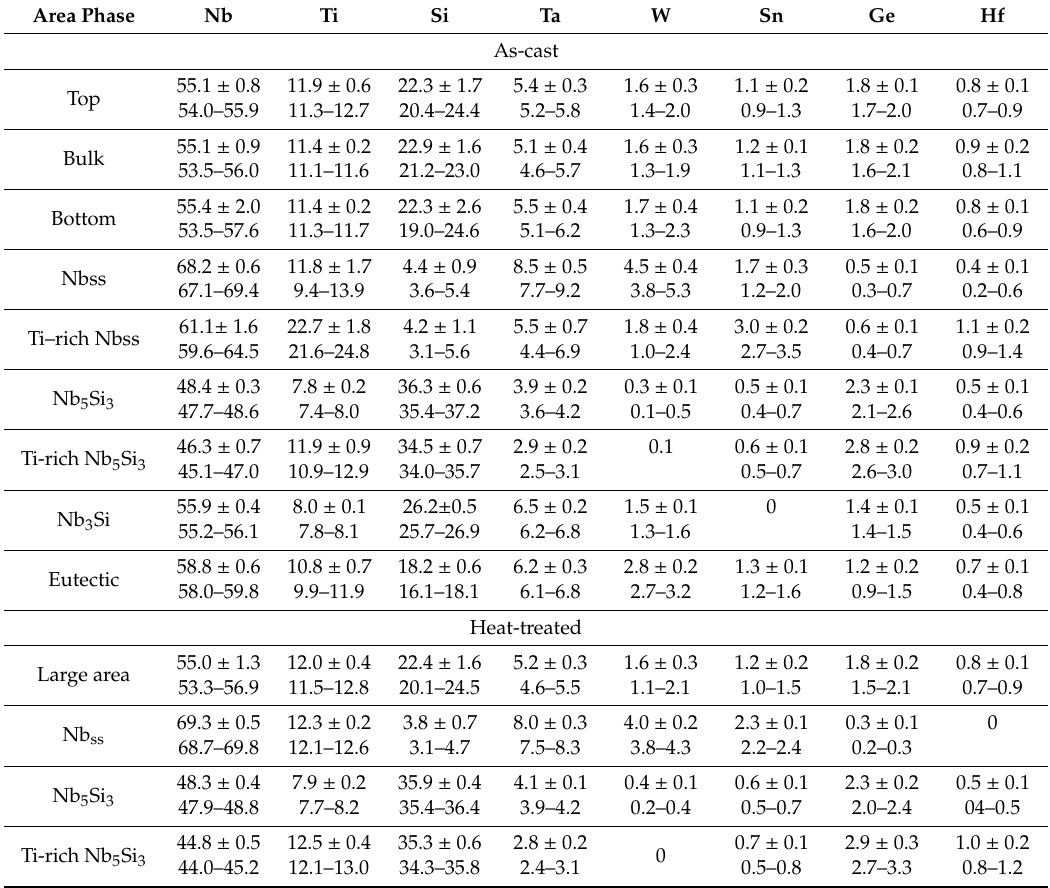
Table 1. The analysis data (at.%) for the alloy JZ1.